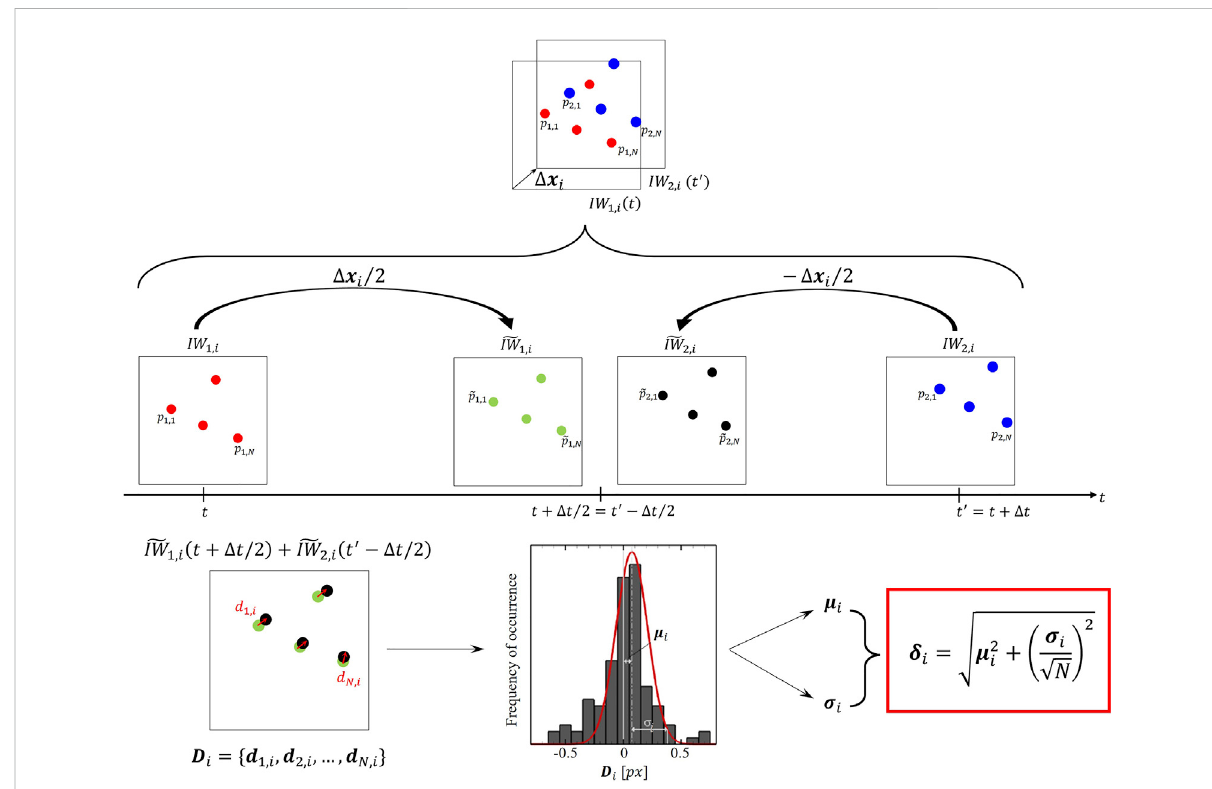
FIGURE 3 Schematic of the particle disparity method applied to the i -th couple of interrogation window IW 1 , i and IW 2 , i on images I 1 ( t ) and I 2 ( t ′ ) , respectively. The particle ensemble displacement in Δ t (cid:1) t ′ − t within the i -th couple of interrogation windows as measured by PIV is Δ x i . (cid:1) IW 1 , i ( t